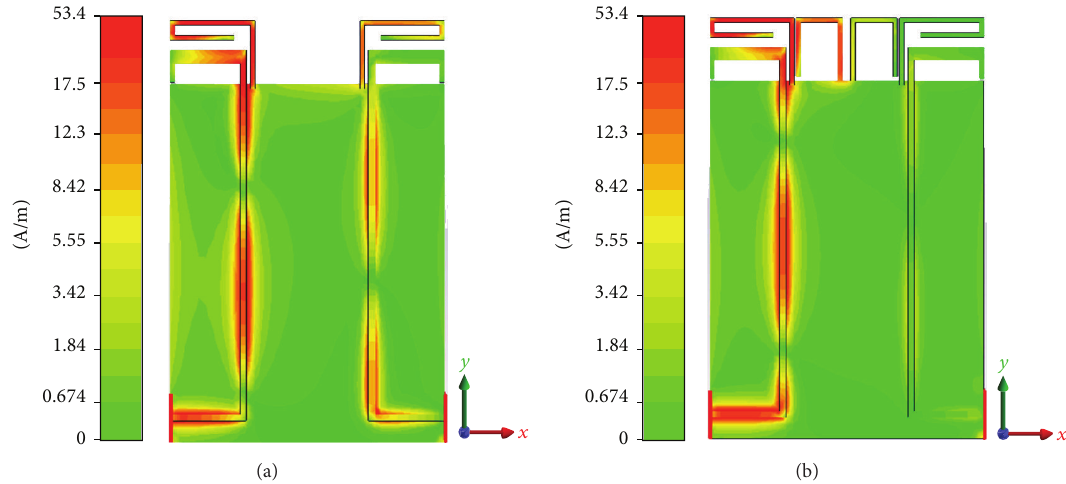
Figure 3: Surface current distribution at 1.6 GHz: (a) without ground branches; (b) with ground